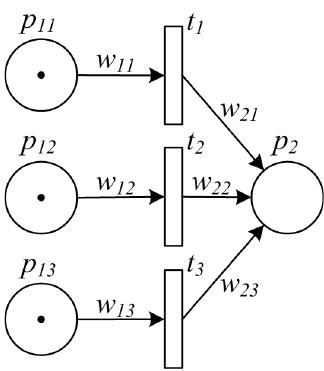
Figure 6. PPN model of simple merge